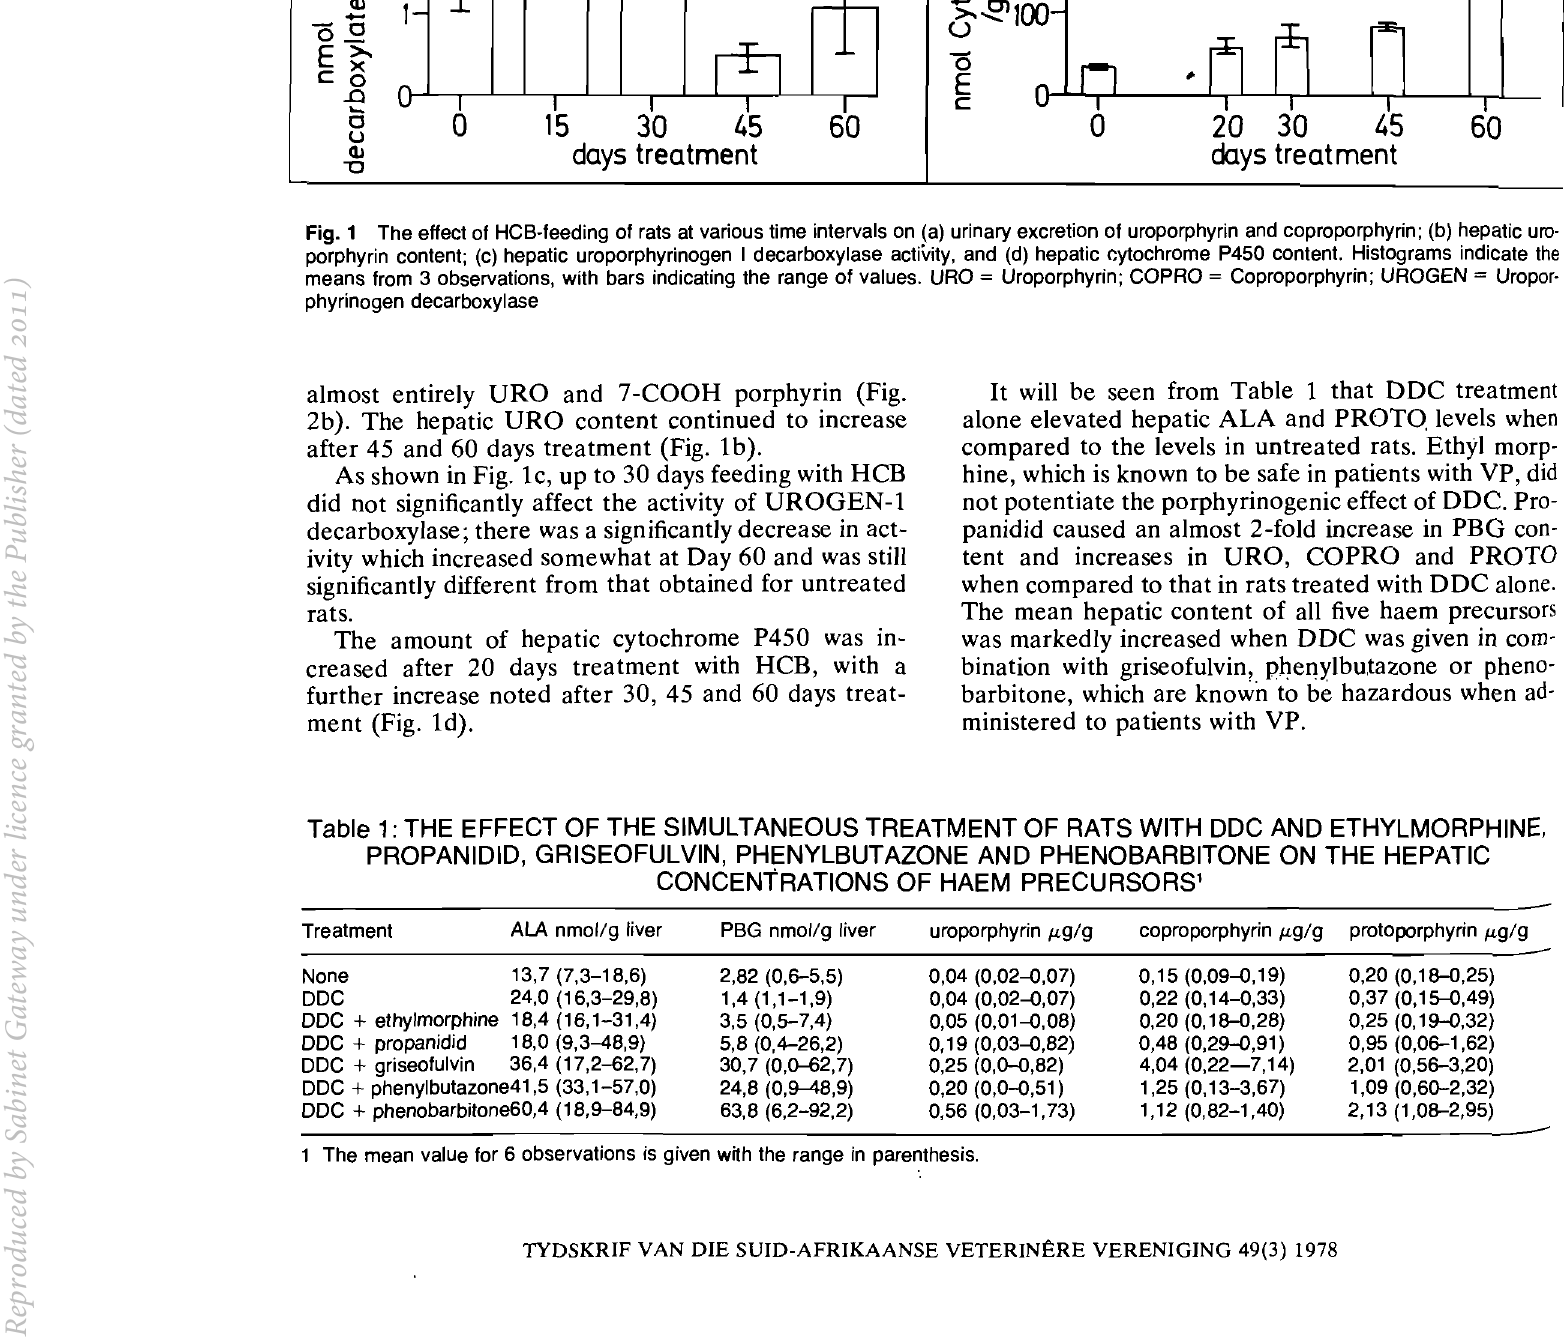
almost entirely URO and 7-COOH porphyrin (Fig.